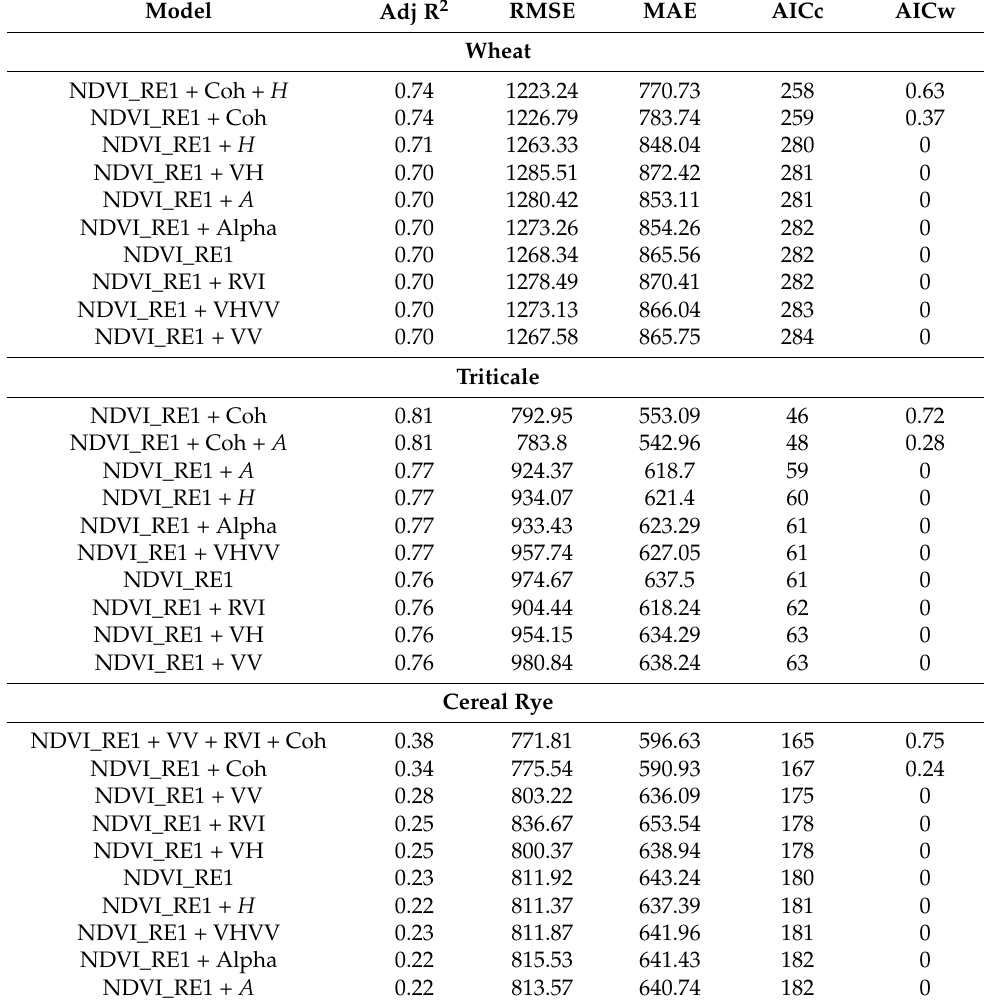
Table 4. Results of combined optical and synthetic aperture radar (SAR) species-specific regression models. Models combined the optical normalized difference red-edge index using band 5 (NDVI_RE1) with SAR backscatter indices (vertical-vertical (VV), vertical-horizontal (VH), VH/VV, and radar vegetation index (RVI)) and polarimetric parameters (alpha, entropy ( H ), anisotropy ( A ), InSAR coherence (Coh)), sequentially. Models were evaluated using goodness of fit (adjusted R 2 ), root mean square error (RMSE), mean absolute error (MAE), and model fit statistics—Akaike’s information criterion for small samples (AICc ) and AIC weights